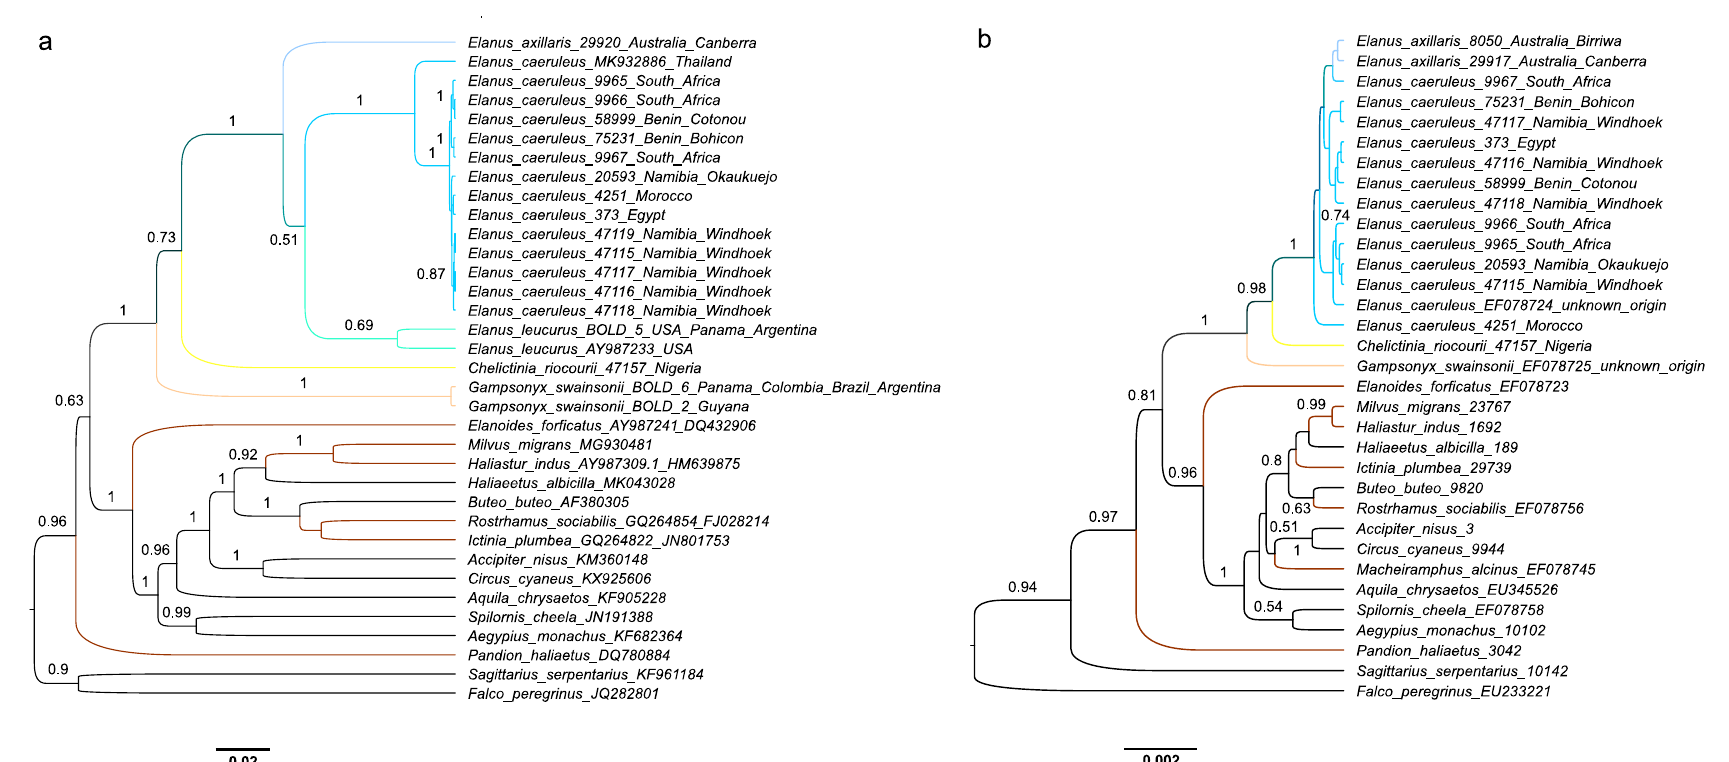
Figure 2. Phylogenetic relationships between taxa of Elaninae (in colors), other kites (in brown), and diurnal raptors based on Bayesian Inference of concatenated mitochondrial dataset Cyt b+COI ( a ) and nuclear dataset RAG-1 ( b ). Posterior probabilities (>0.5) are indicated on the branches, last line represents number of substitutions per site.